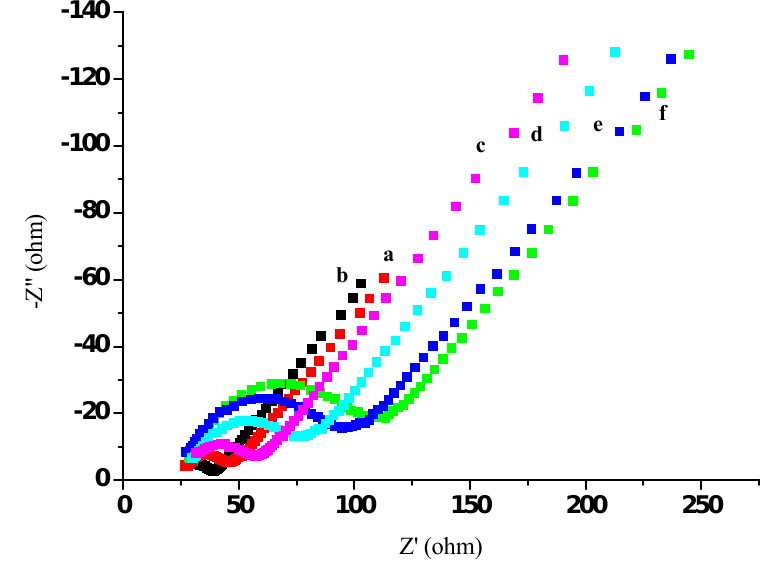
Figure 4. EIS of the different electrodes measured in 5.0 mmol/L [Fe(CN) 0.1 mol/L KCl (pH 6.5): ( a ) Bare GE; ( b ) AuNPs/GE; ( c ) Thiolated protein G/AuNPs/GE; ( d ) AFP Ab1/thiolated protein G/AuNPs/GE; ( e ) BSA/AFP Ab1/thiolated